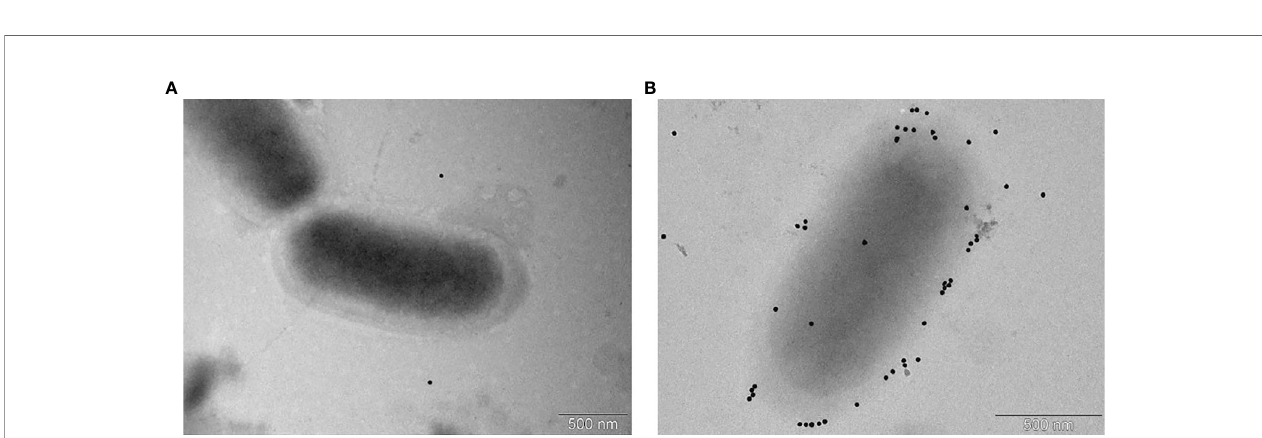
FIGURE 4 | Immunoelectron microscopy of G. parasuis strain CAPM 6475 incubated with pooled sera obtained from pigs before the immunization (A) or after the second immunization with the cCE (B) . Serum antibodies bound to bacteria are indicated by gold particles (black spots) bound to Protein